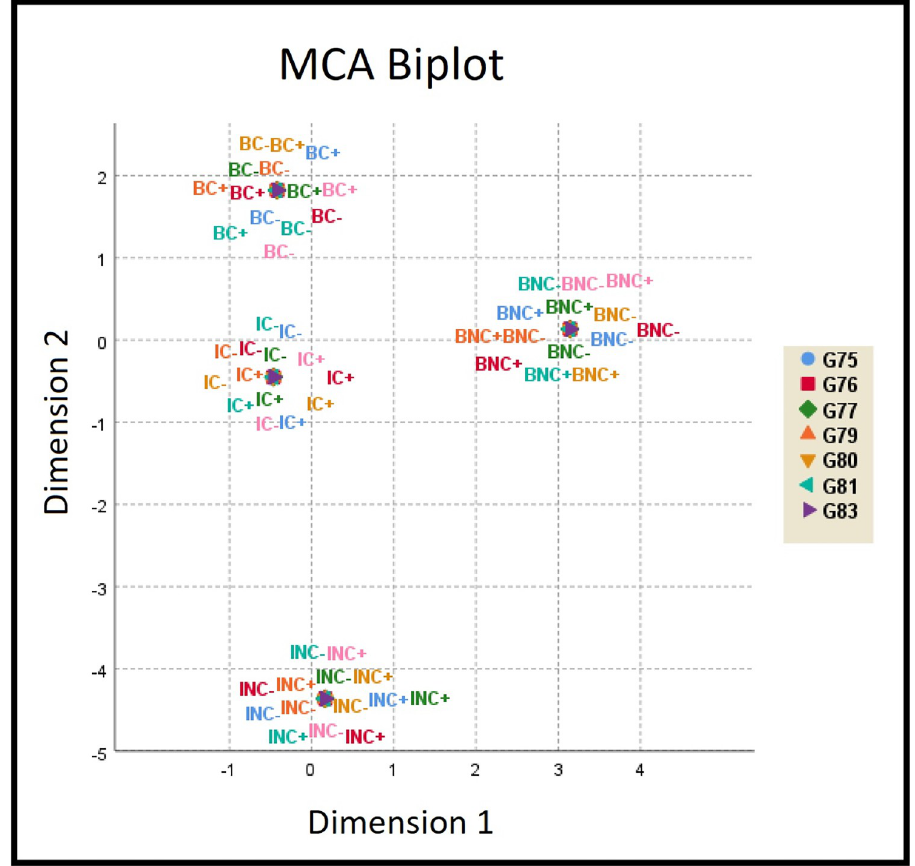
Fig 1. Multiple correspondence analysis biplot considering evolution acceptance and